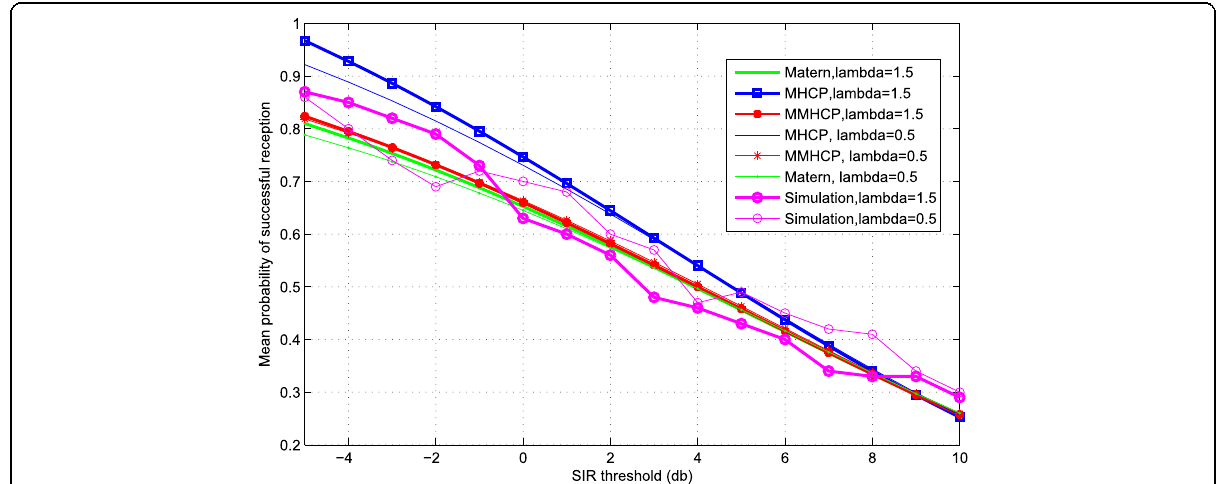
Fig. 11 e_ps for different initial PPP density with the